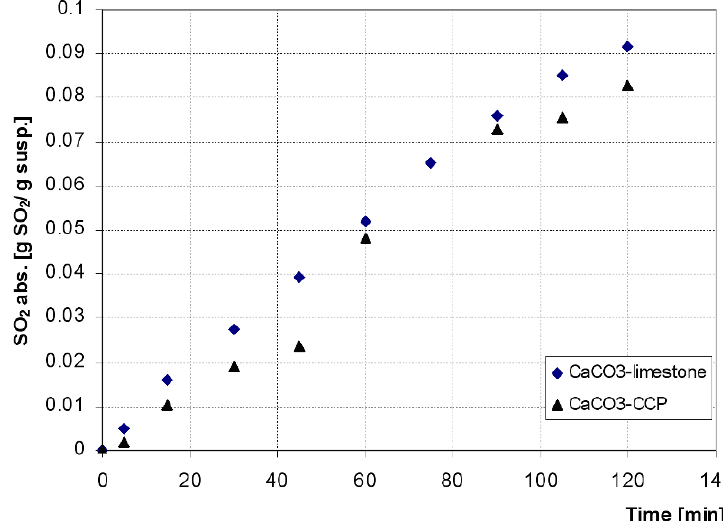
Figure 9. Kinetic data in sulfur dioxide absorption in calcium carbonate slurry with s/l=1/20, dp=0.25 mm and T=298 Fig. 5. In the case of large grains, dp = 0.25 mm, it can be observed that at the beginning of the process, the absorption rate is very low and remains almost constant between 30-45 min. This is the stage of neutral calcium sulphite formation, which due to its extremely low solubility, determines the formation of crust on the surface of carbonate granules. When calcium bisulphite starts forming, it has a much higher solubility compared to the neutral sulphite, the crust is dissolved and the surface of the carbonate granules becomes accessible to SO , so that the absorption rate increases. 2 As the concentration of calcium bisulphite in solution increases, the rate of its dissolution and absorption rate decreases.